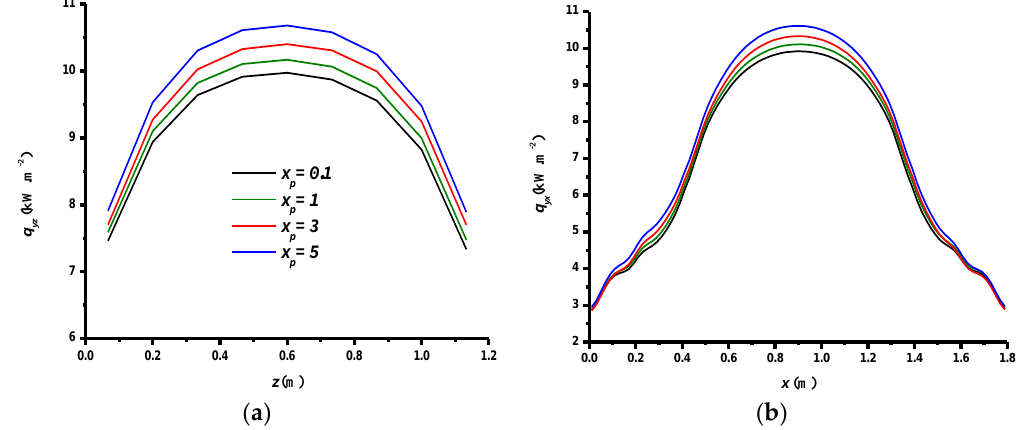
Figure 12. Profiles of the net predicted y -net radiation flux density for fly ash with different particle size parameters ( ω = 0.9 , β = 1 m − 1 ): ( a ) (0.9, 0.0, z ) m and ( b ) ( x , 1.8, 0.6) m.